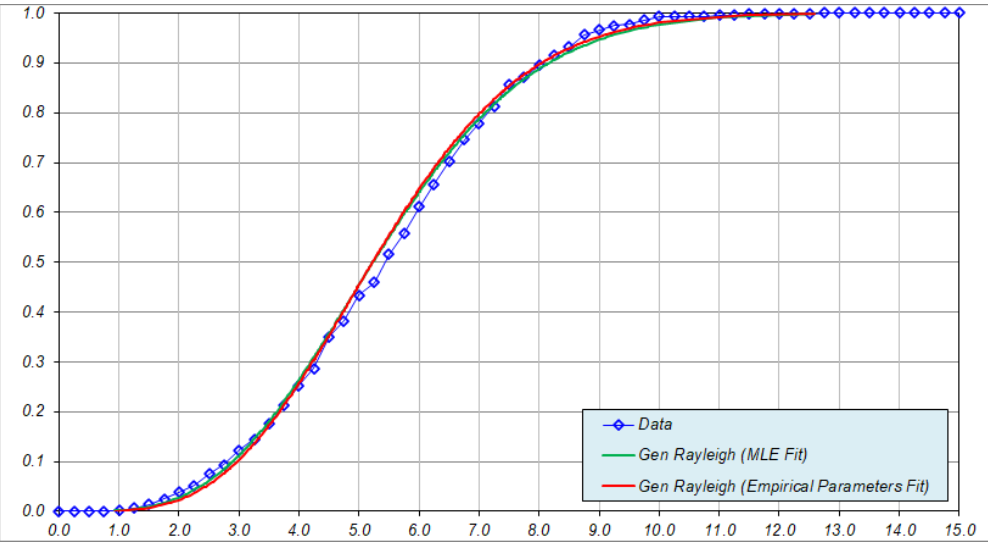
Figure 8. Cumulative Distribution Function (CDF) of the example towed seabed photograph (2015_08_29_131349 in Tables 2 and 3).